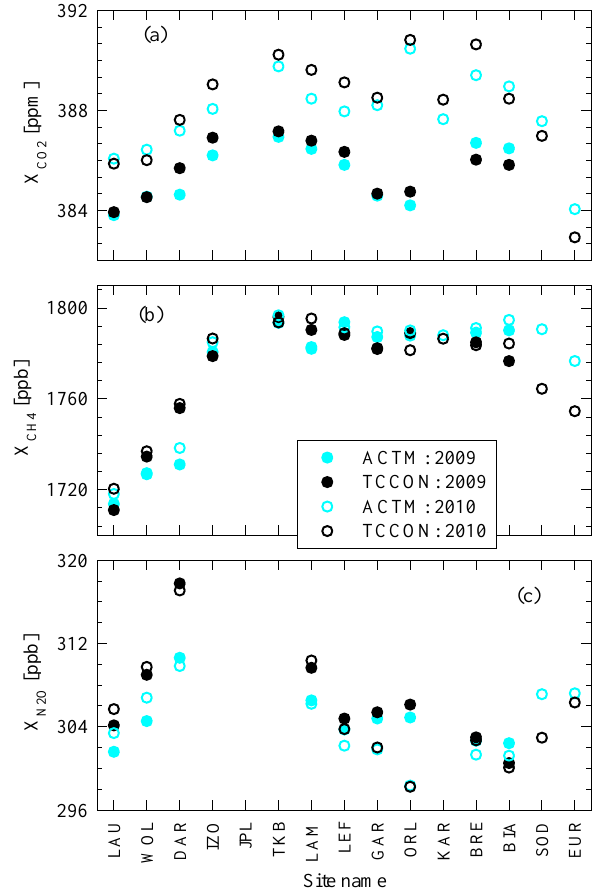
Fig. 3. Observed (black) and simulated (blue) values of X CO (top), 2 X CH (middle) and X N (bottom) at the TCCON sites. Annual 4 2 O mean values for 2009 and 2010 are shown for this comparison (note that there are data gaps in time series for both years). The sites are arranged by latitude from Lauder to Eureka, located at the highest latitudes in the SH and NH, respectively.